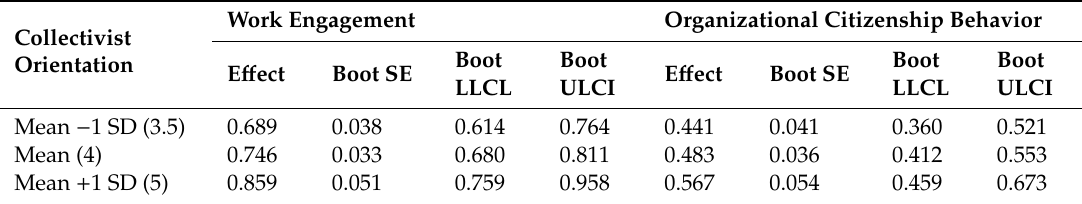
Table 6. The moderation e ff ects of collectivist orientation.